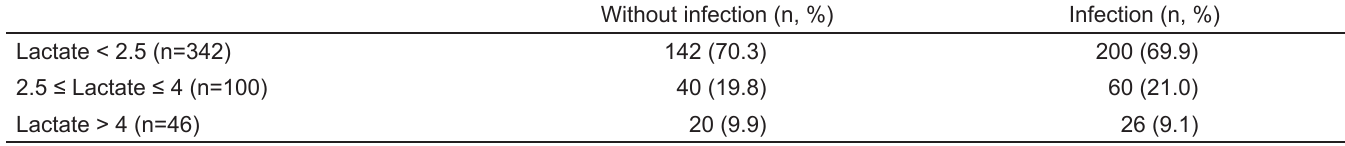
Table 2. Distribution of deterioration by stratified lactate value for both infected and non-infected patients.